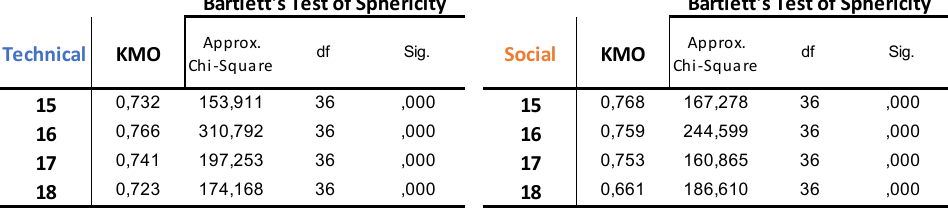
Figure 6. Cattell diagram of components and eigenvalues for the technical field.